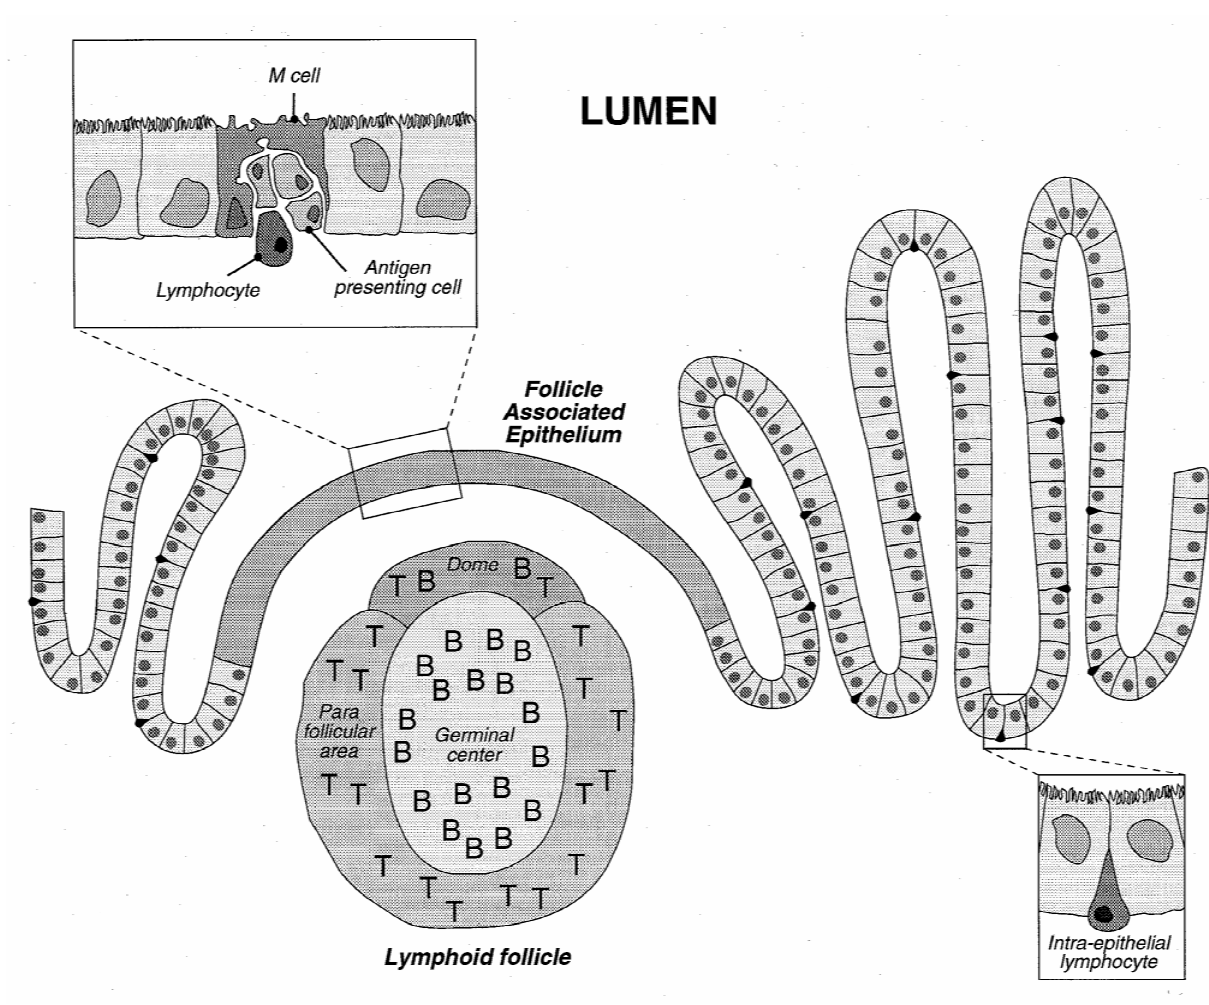
Figure 3 : Schematic representation of the intestinal epithelium with a view of a Peyer's patch and detail of the follicle associated